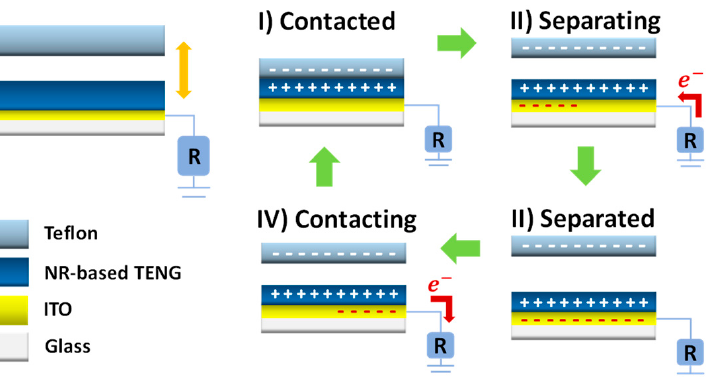
Figure 5. Schematic diagram of the fabricated TENG with working mechanism under a single electrode mode.